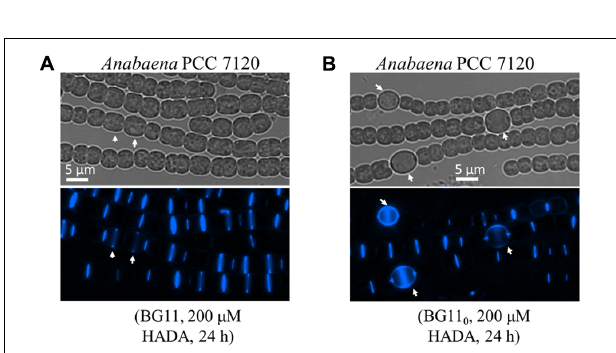
FIGURE 4 | PG synthesis during vegetative growth and heterocyst development in Anabaena PCC 7120. Filaments of Anabaena were grown in BG11 using nitrate as a combined nitrogen source, then incubated with 200 µ M of HADA in BG11 (A) , or in BG11 0 (B) to induce heterocyst development. Arrows in A indicate elongated cells that just started to incorporate HADA at the division site, and in B heterocysts. Bright-field (gray) and HADA fluorescence (blue) images are